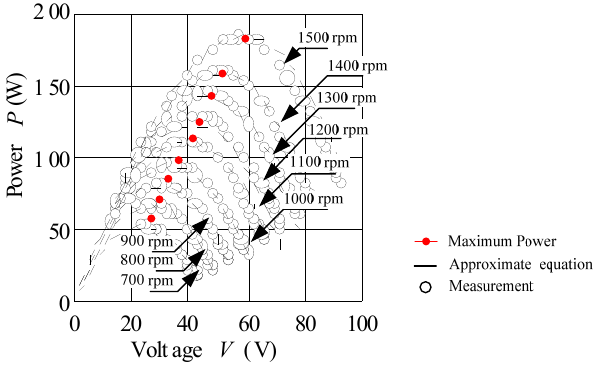
Figure 8. Characteristics of the double ‐ stator generator for each rotation speed.